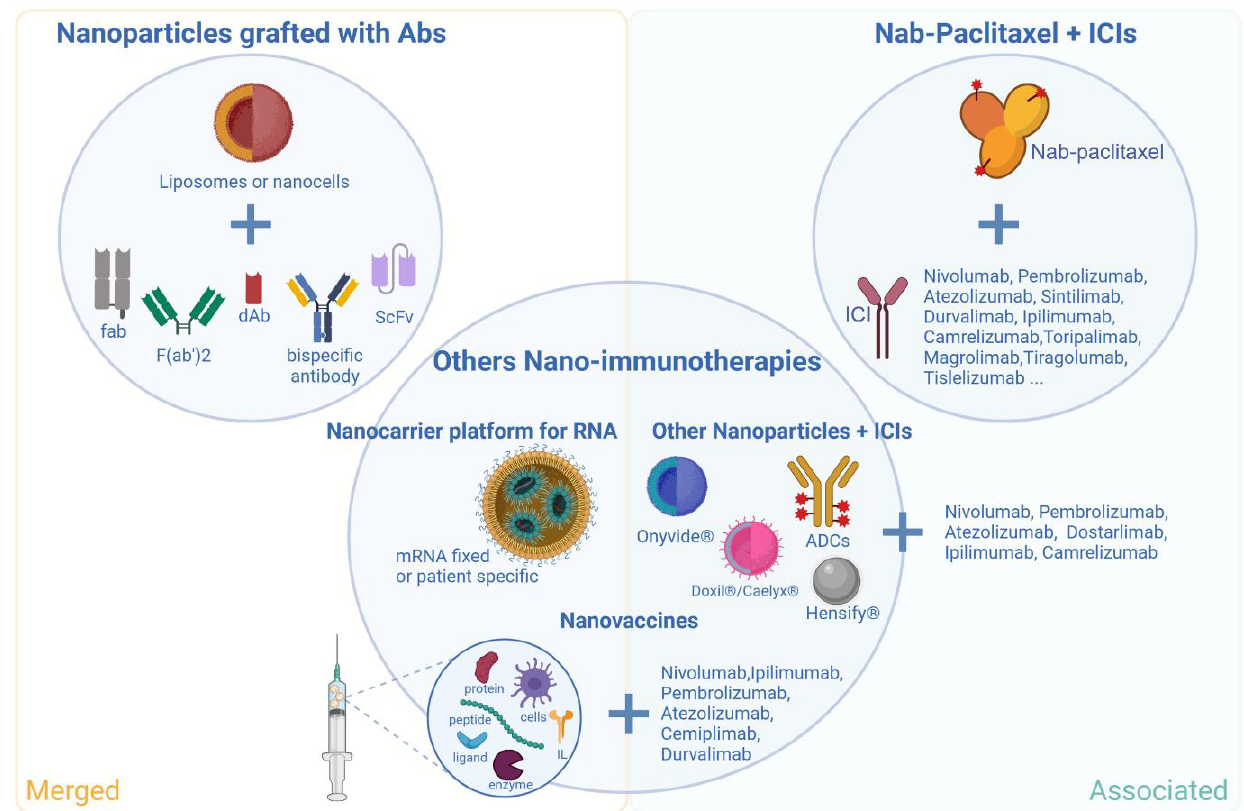
Figure 4. Schematization of the most relevant types of merged (yellow zone) and associated (blue zone) nano-immunotherapies currently under clinical trial in oncology. Merged nano-immunotherapies include nanoparticles (mostly liposomes or nanocells) engrafted with antibodies or fragments of antibodies and nanoparticles used as nanocarrier for immune system activators such as RNA, specific proteins, ligands, enzymes interleukins, or cells. Associated nano-immunotherapies include the combination of ICIs with nab-paclitaxel, nanovaccines, or commercialized nanopar- ticles (i.e., Onyvide®, Doxil®/Caelyx®, ADCs, Hensify®). ADCs = antibody drug conjugates, dAb = single domain antibody, fab = fragment antigen binding, ICI = immune checkpoint inhibitors, IL = interleukins, scFv = single chain variable